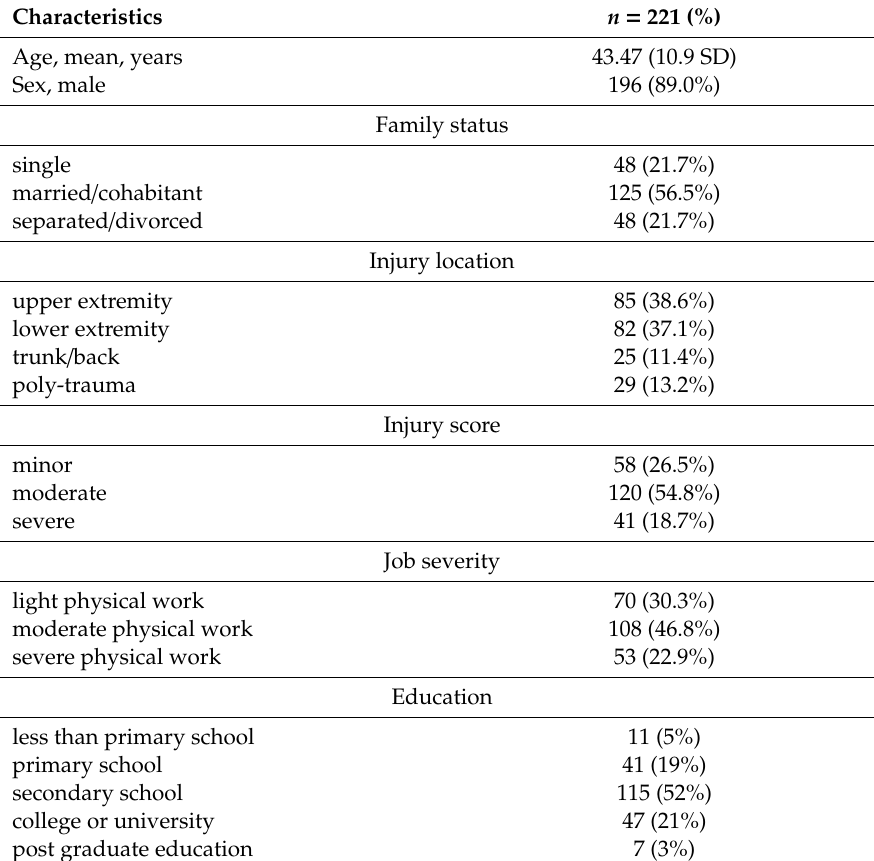
Table 2. Characteristics of study